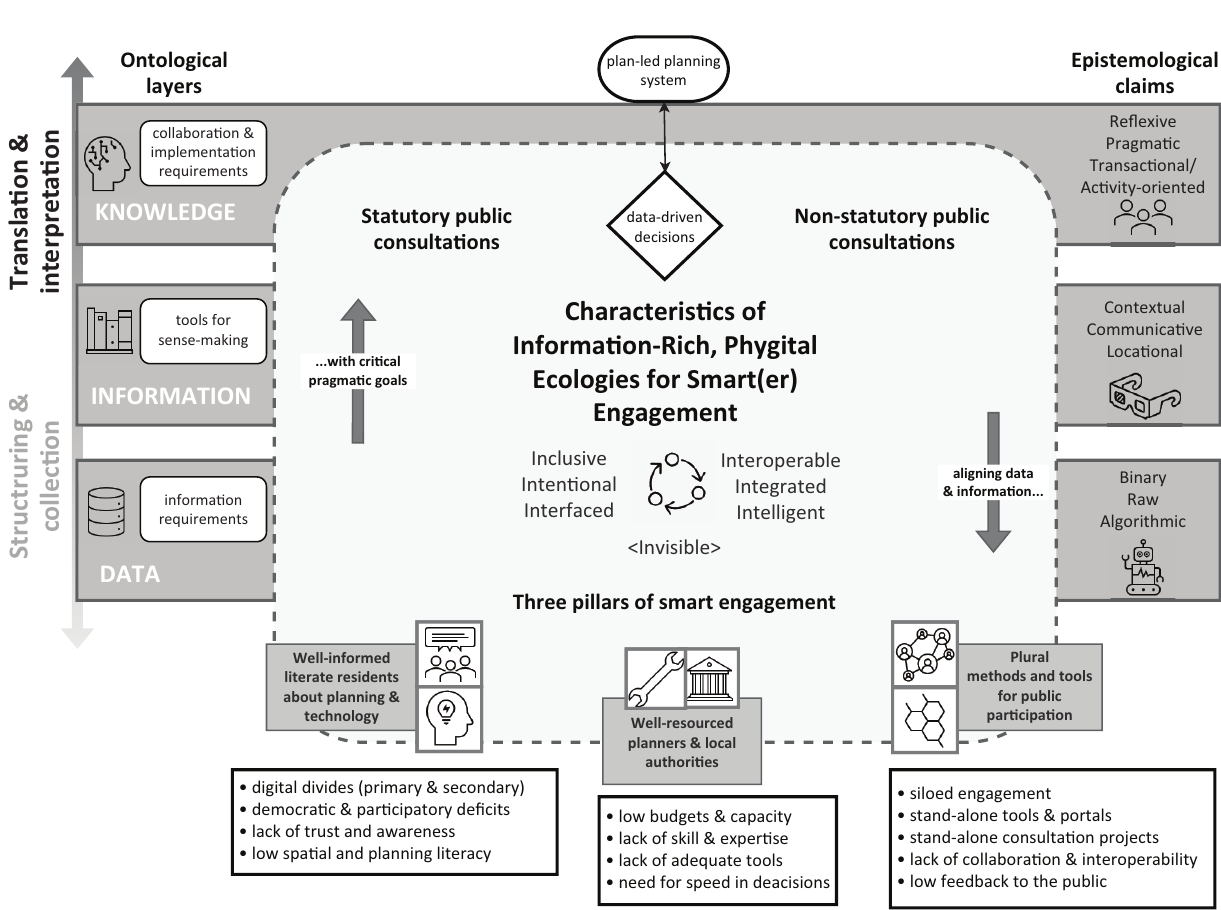
Figure 1. Original conceptual model for effective smart engagement in a digital planning